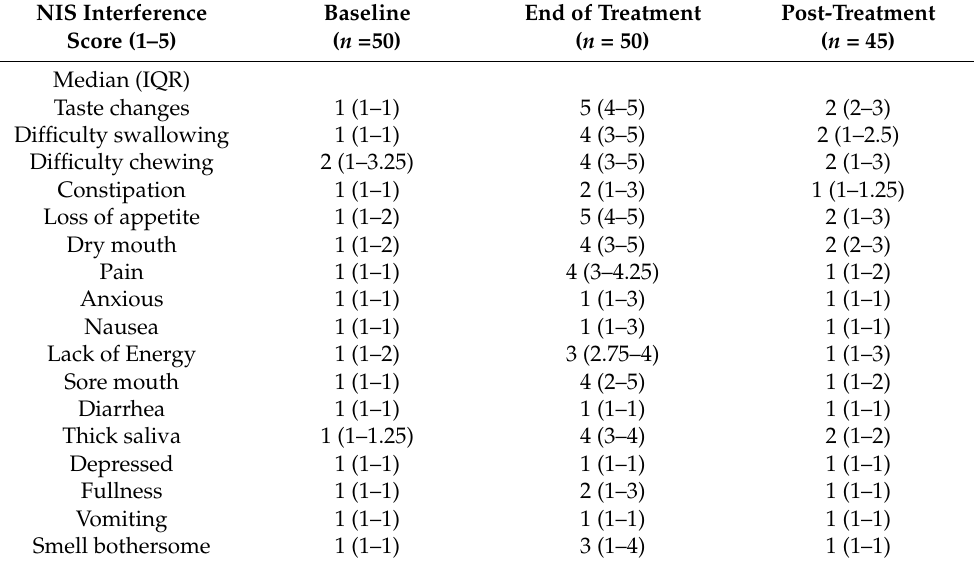
Table 5. Nutrition Impact Symptoms (NIS) interference scores from the Head and Neck Symptoms Checklist (HNSC©) of the patients ( n = 50) at baseline, end and